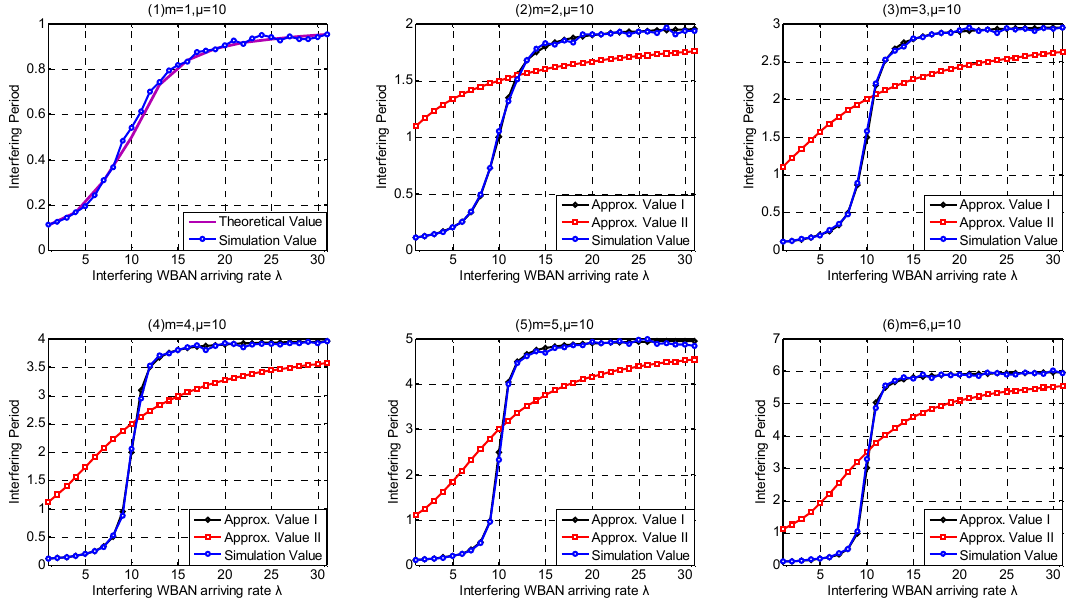
Figure 21. Interfering Period in Service-dependent